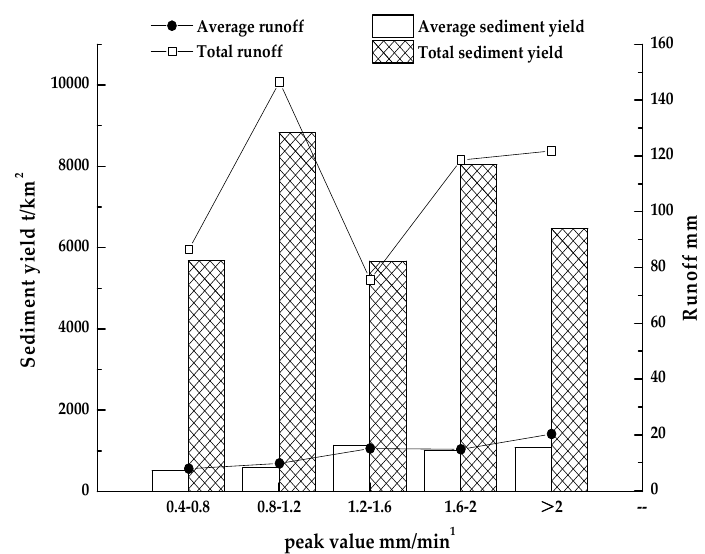
Figure 3. Runo ff and sediment yield characteristics of di ff erent peak values of the rainfalls. Figure 3. Runoff and sediment yield characteristics of different peak values of the rainfalls.